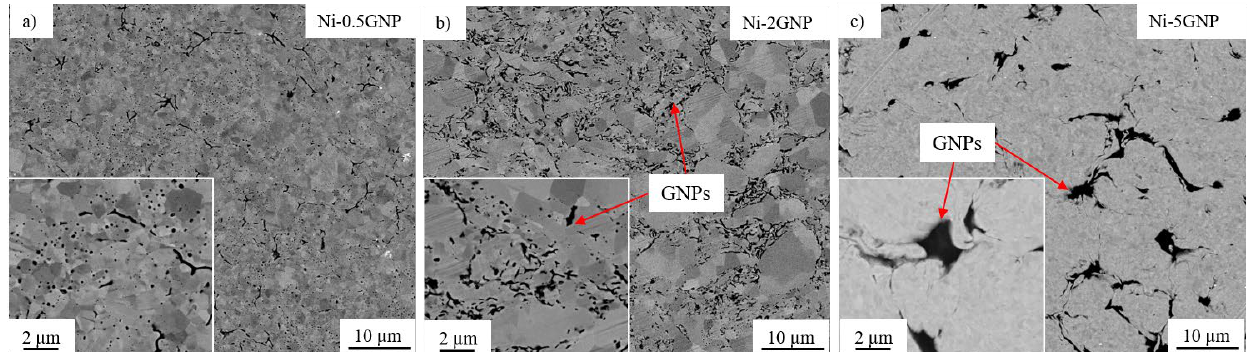
Figure 4. SEM micrographs of ( a ) Ni-0.5GNP, ( b ) Ni-2GNP, ( c ) Ni-5GNP